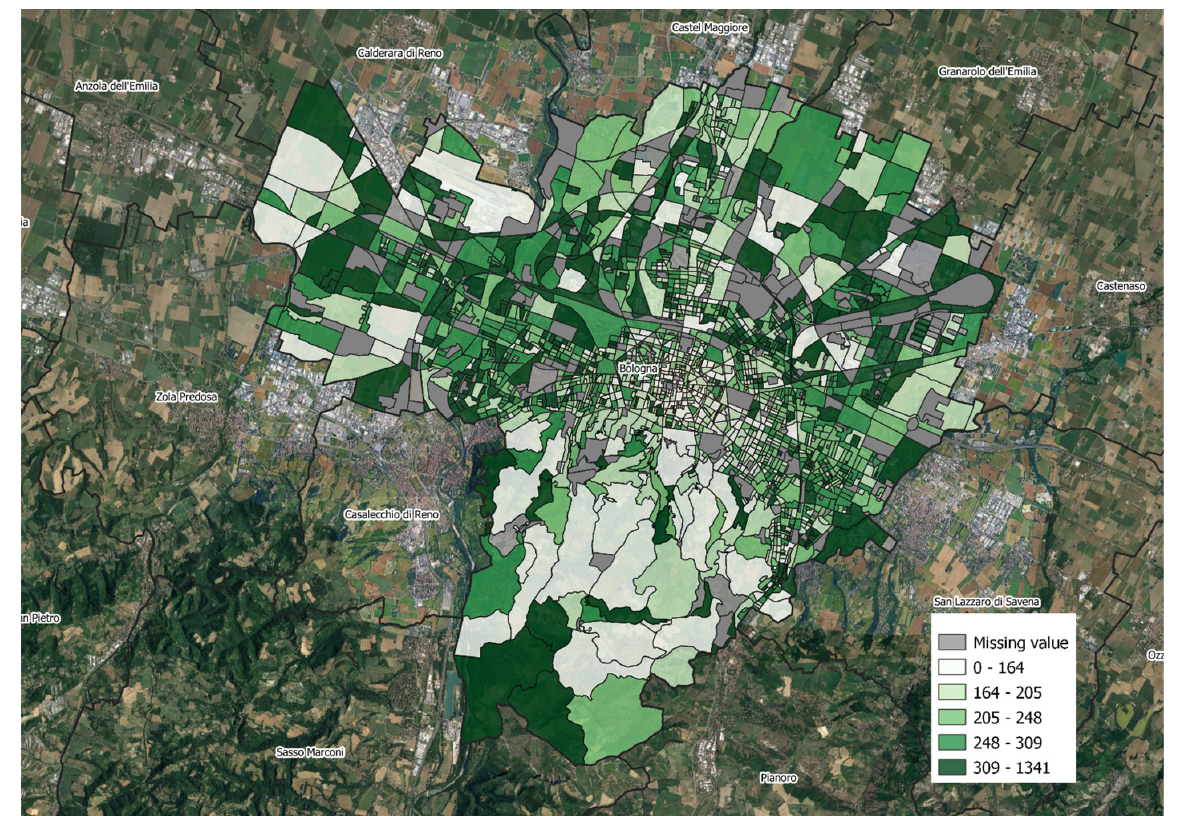
Figure 3. Map of the distribution of the EDV rate ×100, Bologna. The map does not include the block with a rate of 171.4%, because it was derived from a tiny population ( n = 7). As shown in Table 4, according to the global model, the EDV rate in the days (lag 0–1) with a temperature over 26 ◦ C increases with mean age (+0.55% for each additional year) and with the deprivation index (+5.63% for each additional point) and, conversely, it diminishes with an increase in the MD index: for each increase of 0.1 point in the microclimatic index, the rate decreases by 3.46%, keeping the effect of the other covariates constant. The EDV rate also decreases by 3.29% for an increase of 1.000 euros and by 0.56% for each percentage point of males. Table 4. Relationship between EDV rate during days with temperature >26 ◦ C and census block characteristics. Estimates of Poisson and GWRP model. * Some census blocks were not considered because of missing